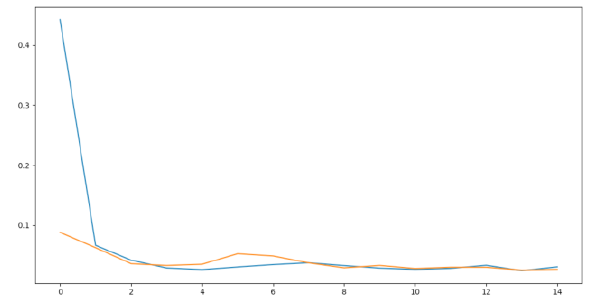
Fig. 8. Learning error. Number of predicted parameters is 6.